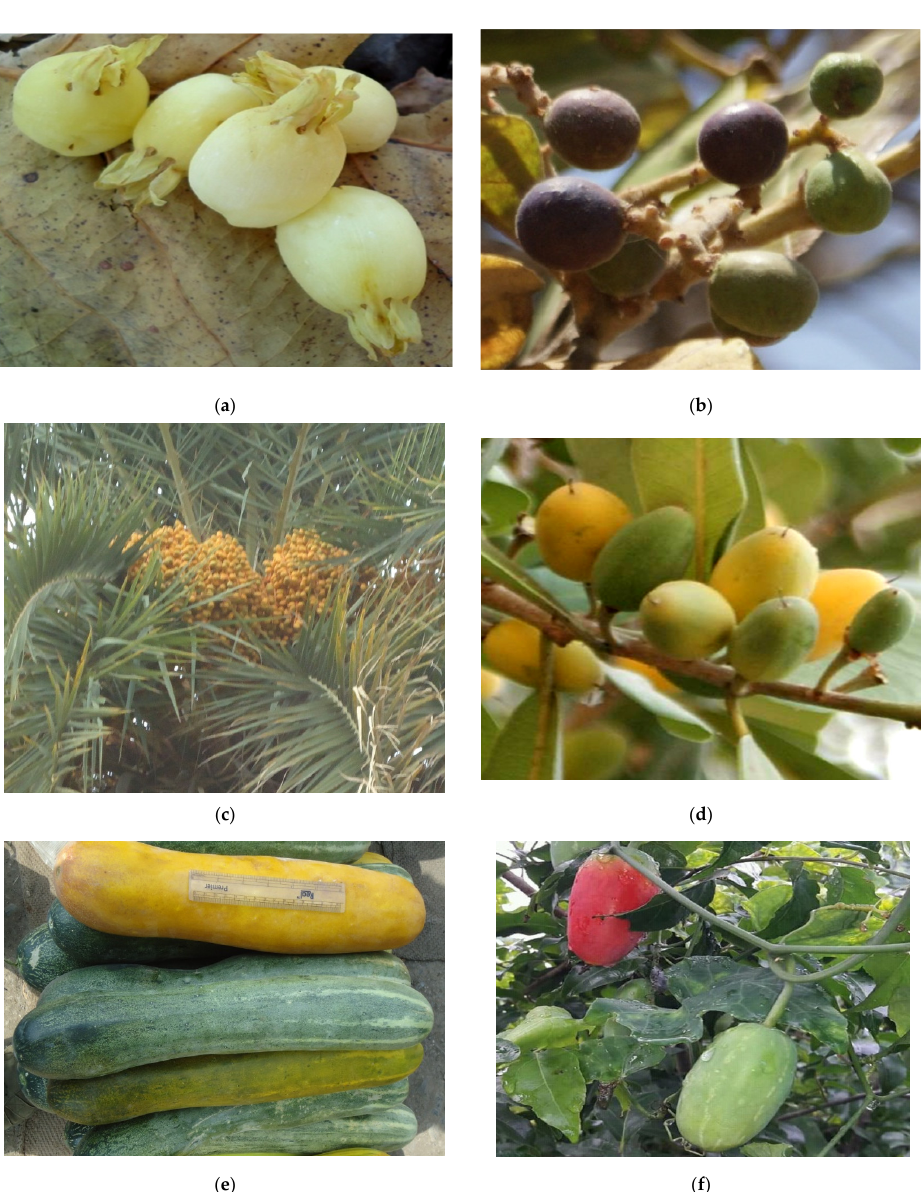
Figure 2. Edible Fruits in the wild/forest areas and villages: used as supplement to food ( a ) Madhuca latifolia J.F. Gmelin; ( b ) Buchnania lanzan Spreng; ( c ) Phoenix sylvestris Roxb; ( d ) Manilkara hexandra (Roxb.) Dubard; ( e , Cucumis sativus ; f , Coccinia grandis ).